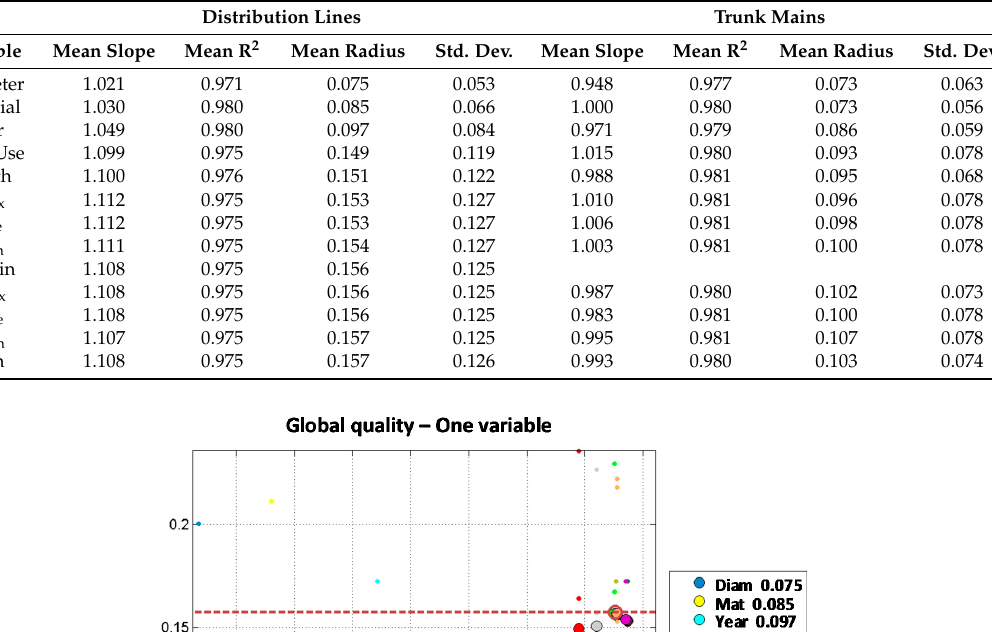
Table 4. One variable models: predictive capacity for distribution lines (left) and trunk mains (right) networks.